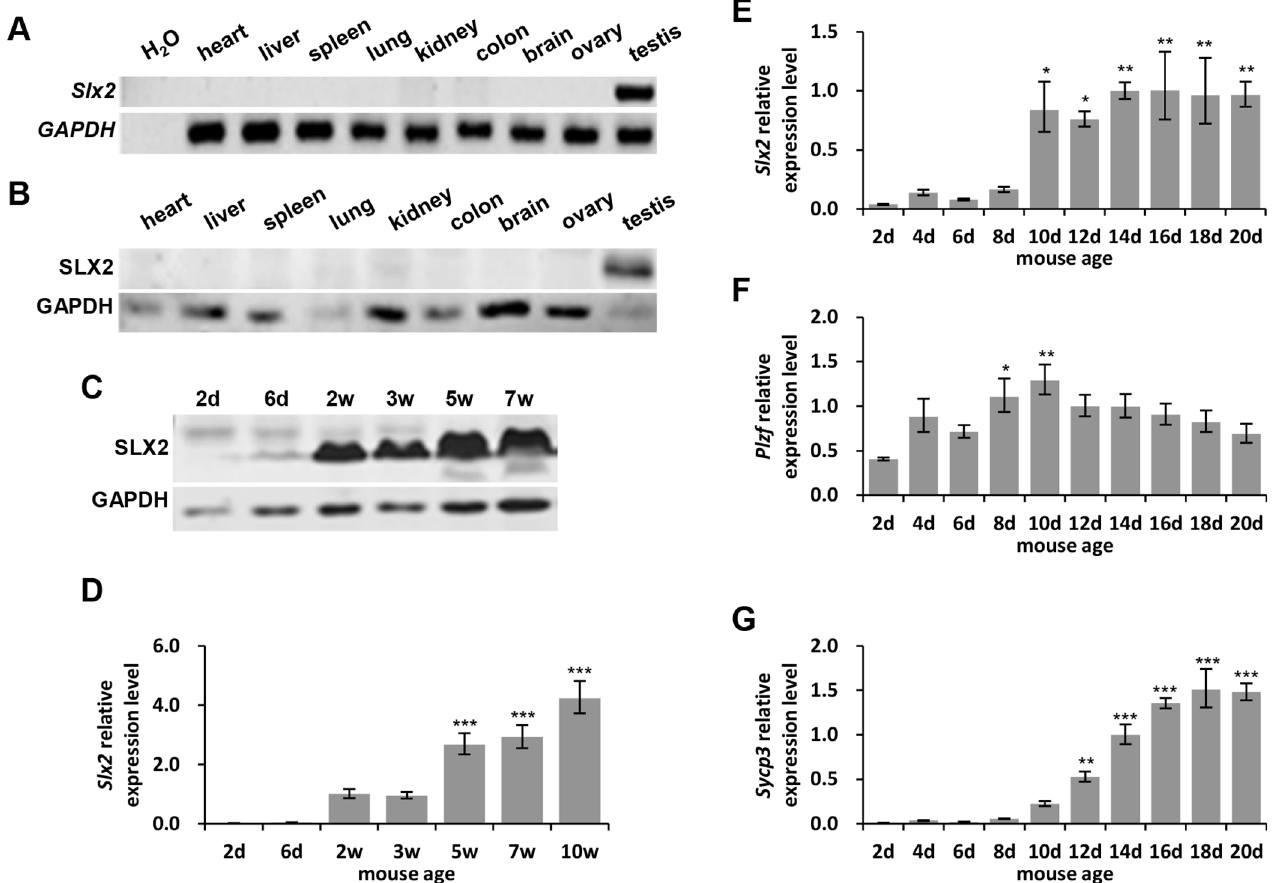
Fig 1. Specific expression of SLX2 in mouse testis. A) Semi-quantitative RT-PCR analysis of Slx2 in different tissues from 3 weeks old mice. B) Western blot analysis of SLX2 in different tissues from 3 weeks old mice. C) Western blot analysis of SLX2 in testis from mouse of different ages. D) Quantitative real- time PCR analysis of Slx2 in testis from mouse of different ages. E) – G) Quantitative real-time PCR analysis of Slx2 (E), Plzf (F) and Sycp3 (G) expression levels in mouse testes during the first wave of spermatogenesis. d, days; w, weeks. Quantitative real-time PCR gene expression level was normalized by Gapdh level. Data were analyzed by applying one way ANOVA and Holm-Sidak test. Expression levels were considered significantly different from the 2d group when P < 0.05 ( * ), 0.01 ( ** ) or 0.001 ( *** ).